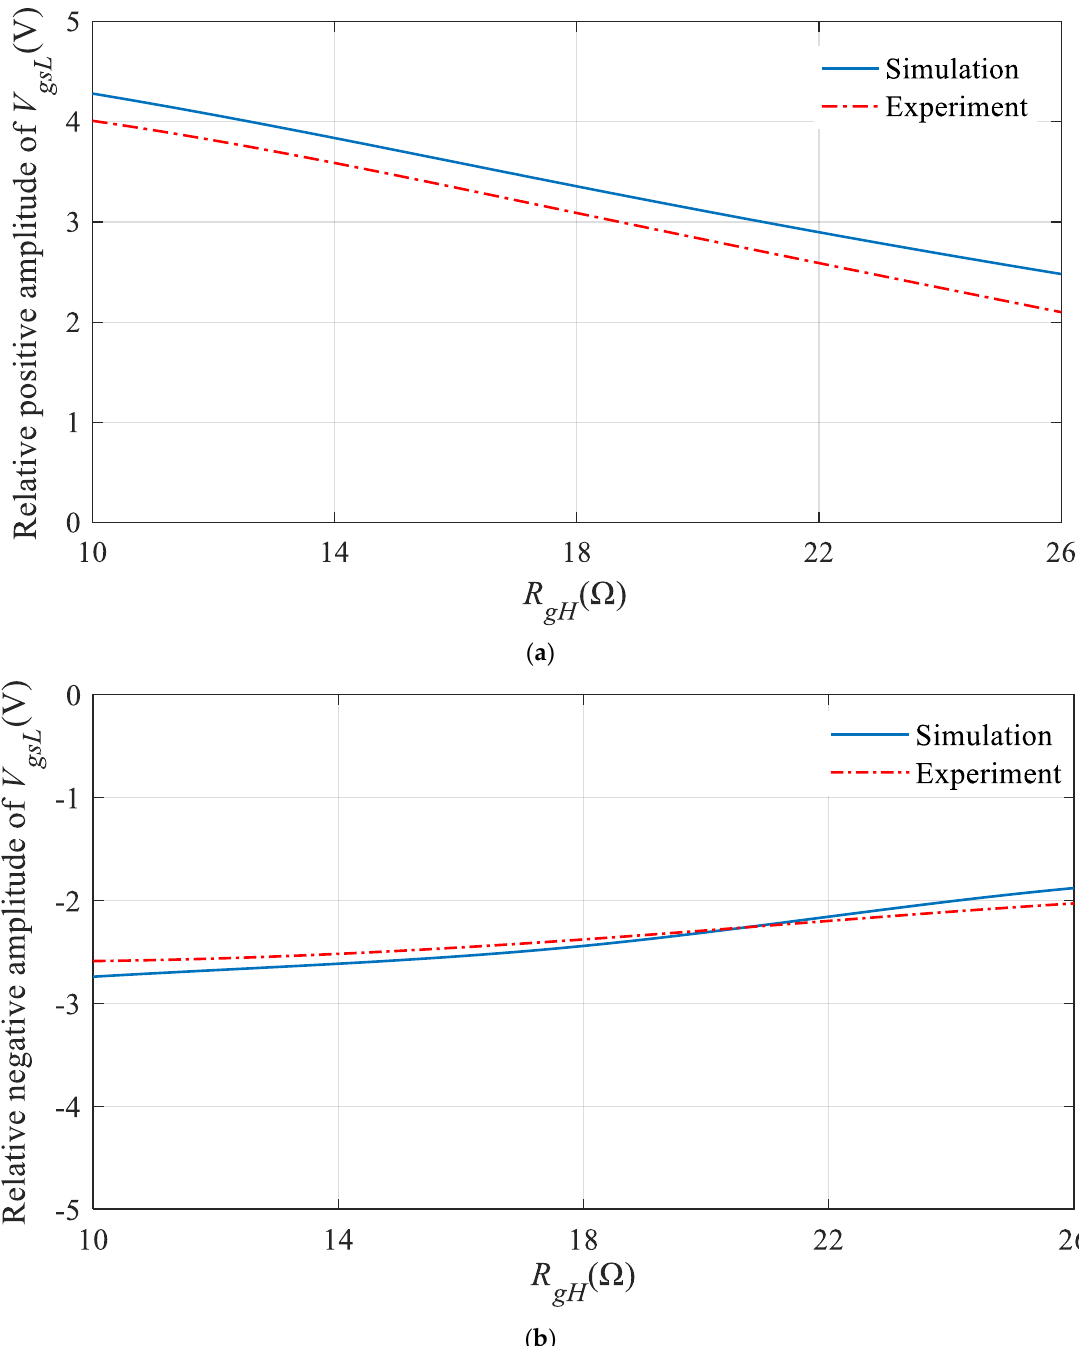
Figure 22. Comparison of simulation and experimental variation trend of relative crosstalk peak value with different R gH . ( a ) turn-on. ( b ) turn-off.